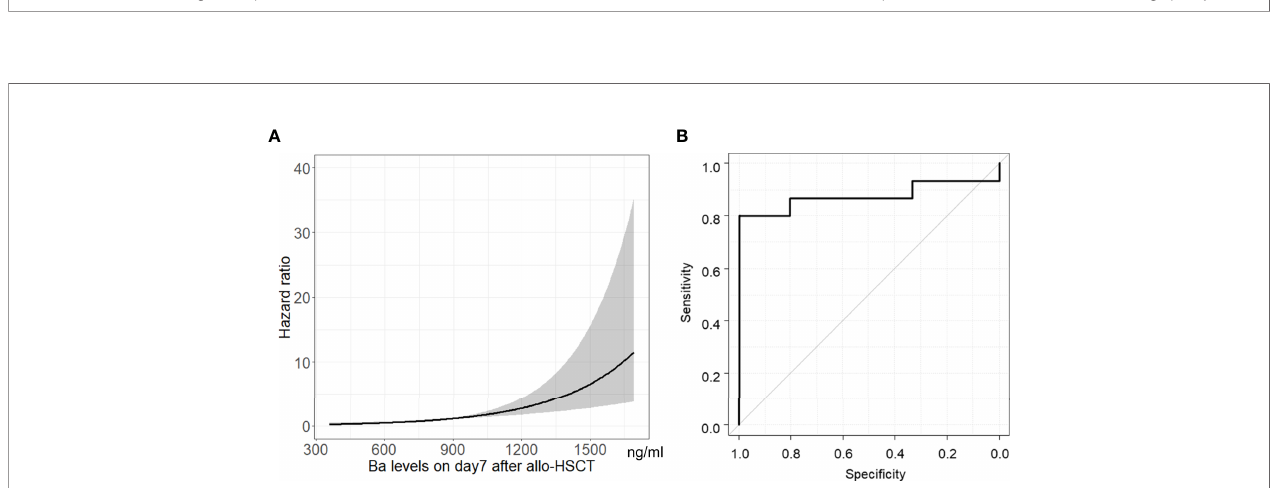
FIGURE 3 | Association between Ba levels on Day 7 following allo-HSCT and TA-TMA development. Hazard ratio (A) and ROC curve (B) of Ba levels on Day 7 following allo-HSCT for TA-TMA development are shown. Gray shadow shows 95% CI of hazard ratio. allo-HSCT, allogeneic hematopoietic stem cell transplantation; CI, con fi dence interval; ROC, receiver-operating characteristic; TA-TMA, transplant-associated thrombotic